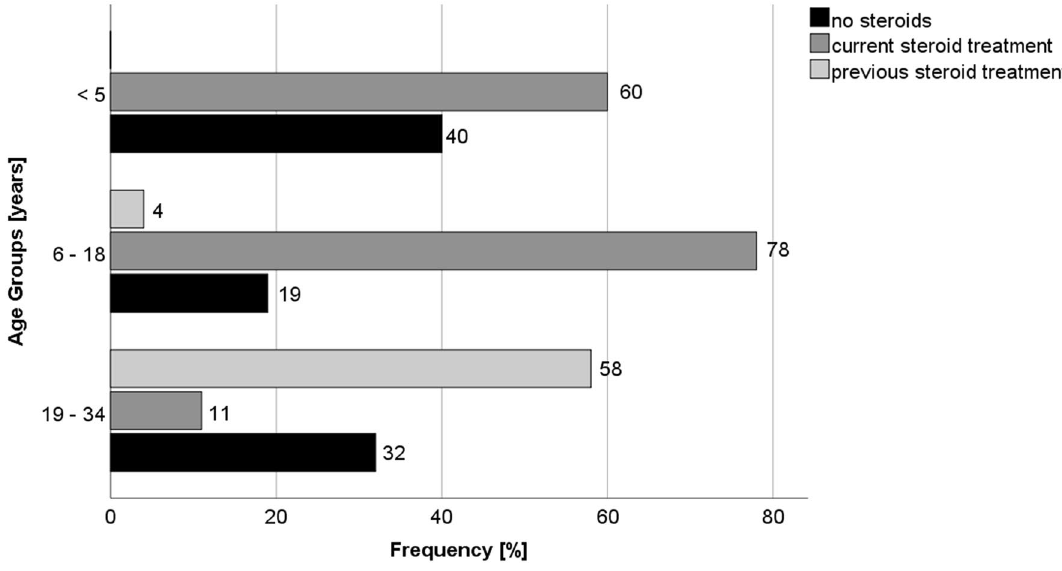
Figure 4. Corticosteroid therapy by age groups